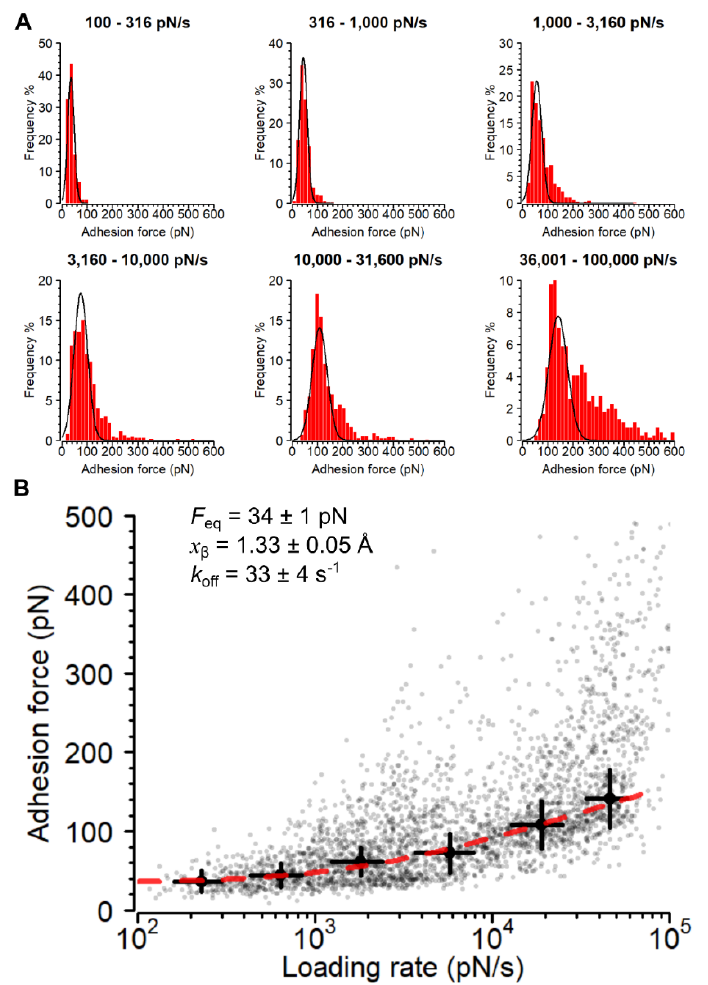
Figure 4. Mechanical stress strengthens the Ag85-Fn interaction. ( A ) Adhesion force histogram plots at different loading rates ( n = 3,188 curves from 13 cells). The Gaussian distributions represent rupture events for single bonds. ( B ) Dynamic force spectroscopy plot showing Ag85-Fn binding force activation under mechanical stress. Large circles and error bars represent means and standard deviations calculated for the first Gaussian distributions at each loading rate as shown in panel A. The dashed red line represents the fit of the Friddle–Noy–de Yoreo model to the pooled data from the Gaussian bins in panel A ( n = 2420 data points).